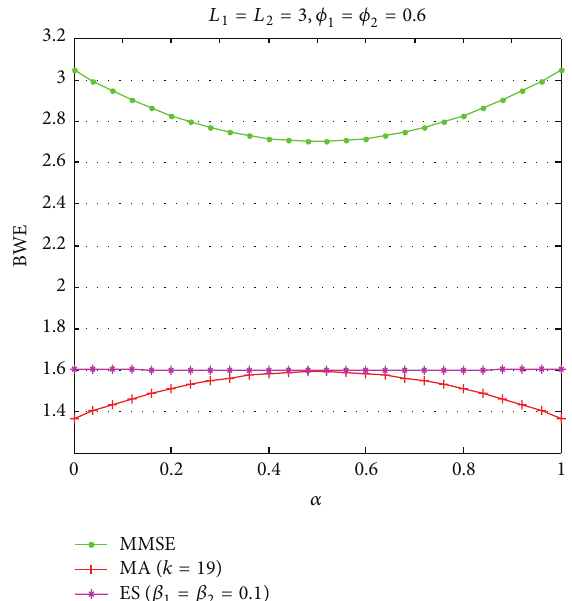
Figure 15: Comparison of three different forecasting methods by varying 𝛼 ( 𝑘 = 3 ).